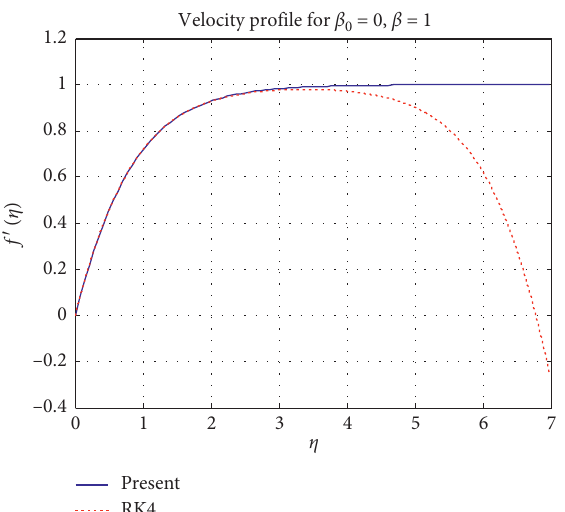
Figure 5: Velocity profile of the Pohlhausen flow ( β